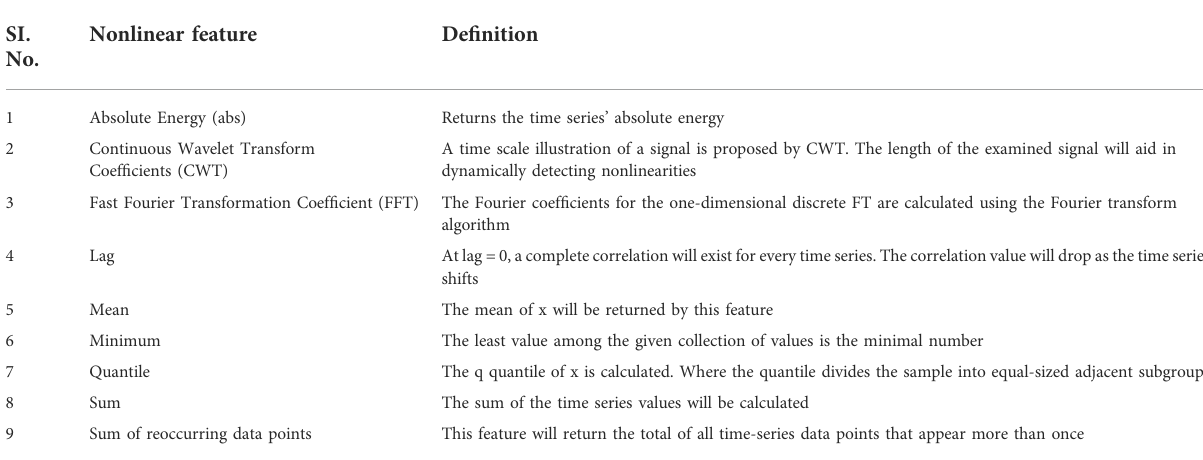
TABLE 2 Important non-linear